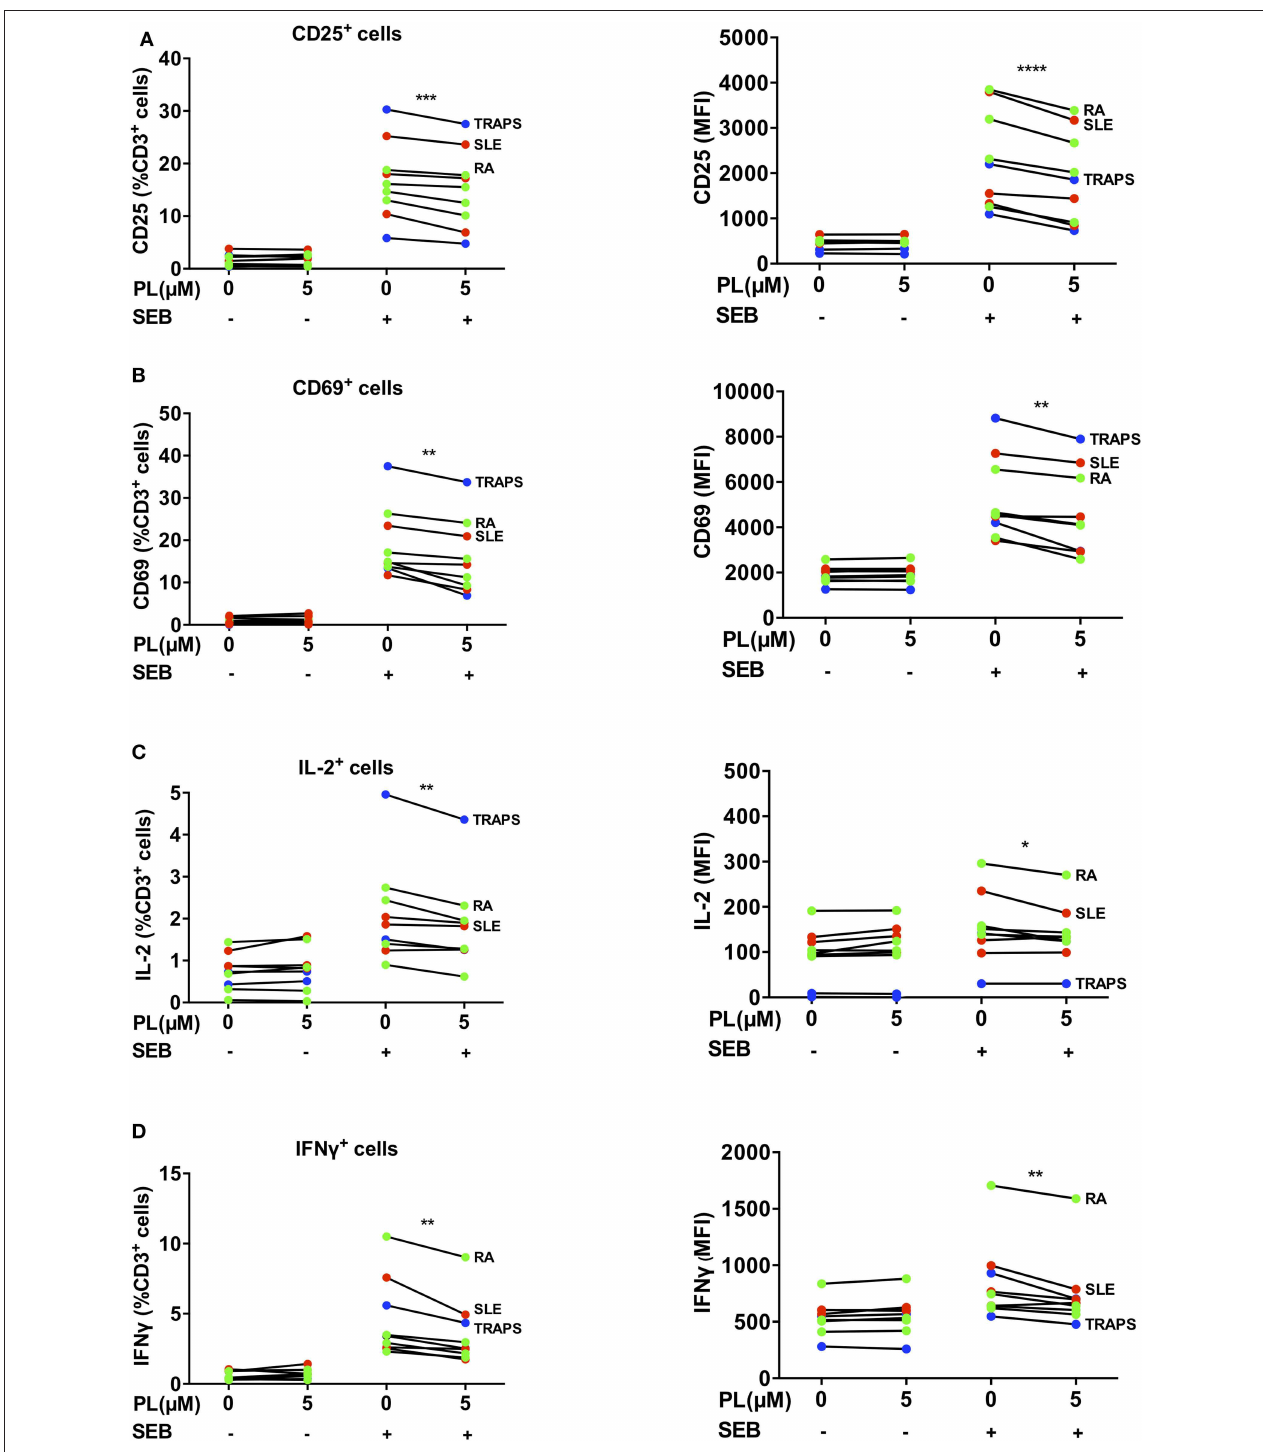
FIGURE 7 | PL downregulates CD69, CD25, IL-2 and IFN γ in lymphocytes of patient-derived whole blood samples . (A–D) Whole blood samples from patients with RA (green), SLE (red) and TRAPS (blue) were treated with or without PL and activated with SEB overnight followed by erythrocytes lysis and subsequent immunofluorescence staining and flow cytometry. The CD3 positive cells within the white blood cells were analyzed for expression of (A) CD25, (B) CD69, (C) IL-2, and (D) IFN γ . Shown are percent positive T cells (left) and MFI (right). Statistical analysis was conducted using paired t -test ( n = 8; mean; SEM; * p < 0.05, ** p < 0.01, *** p < 0.001, **** p <